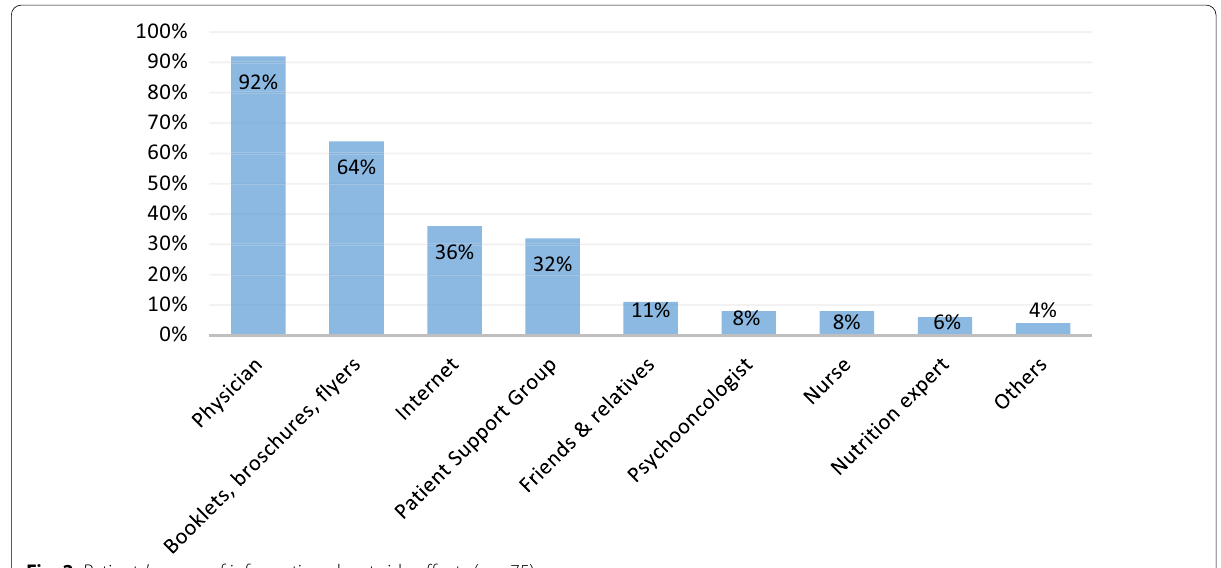
Fig. 2 Patients’ source of information about side effects (n